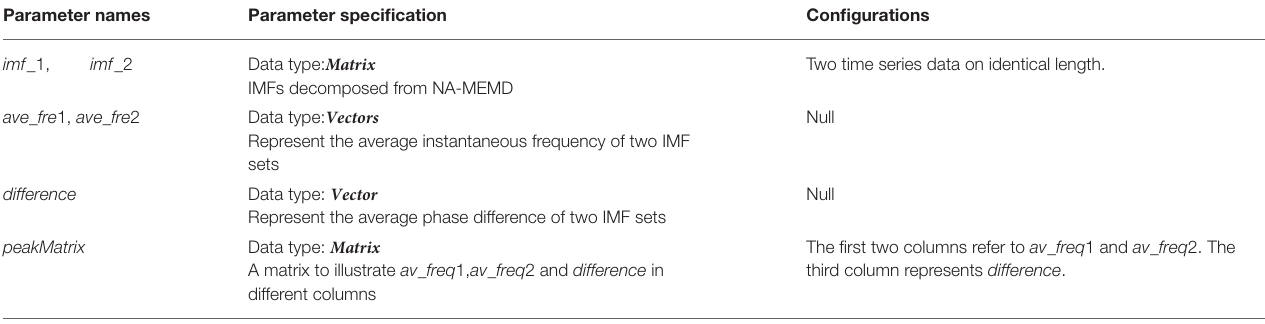
TABLE 3 | Parameter configurations for function causal _ decomposition